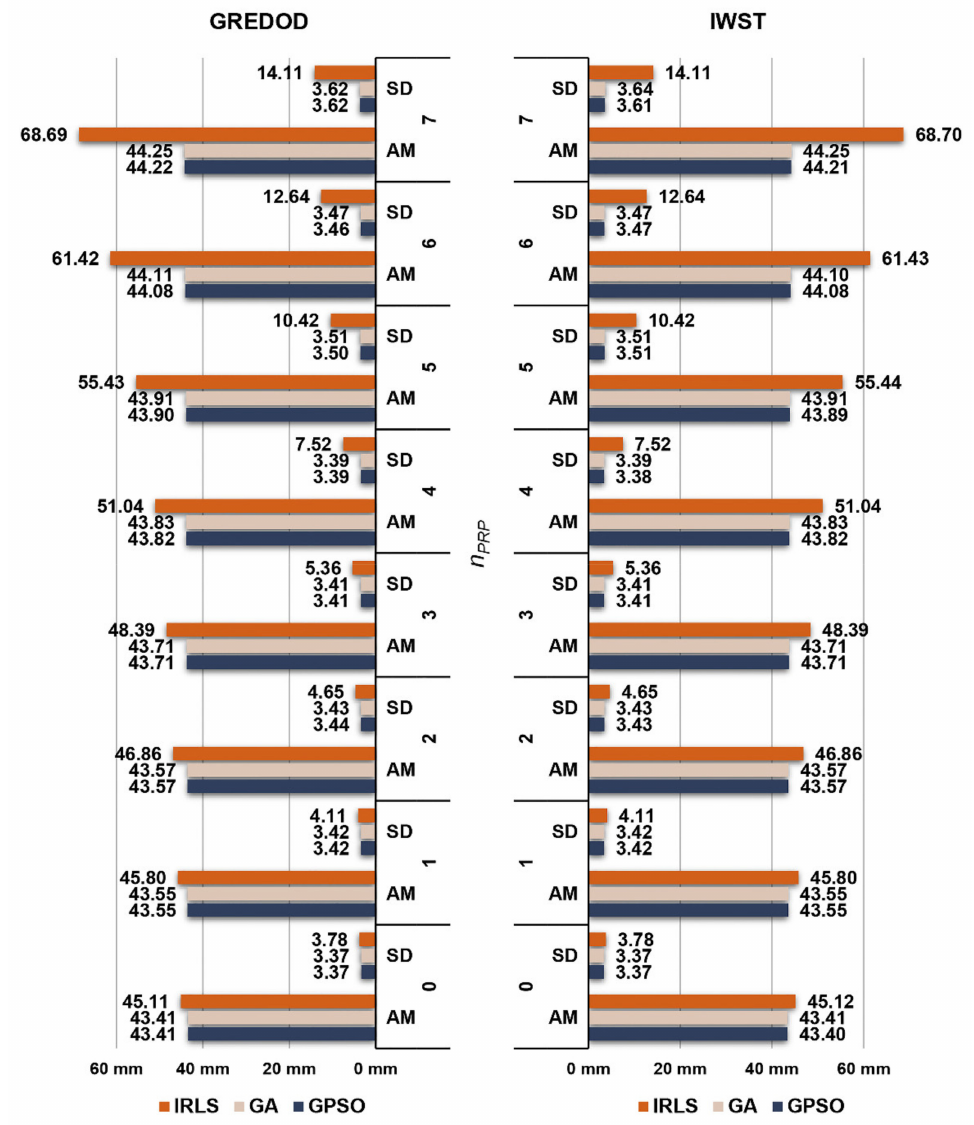
Figure 9. Arithmetic mean (AM) values and standard deviations (SDs) of overall absolute true errors e ˆ of the GREDOD and IWST methods for variant d